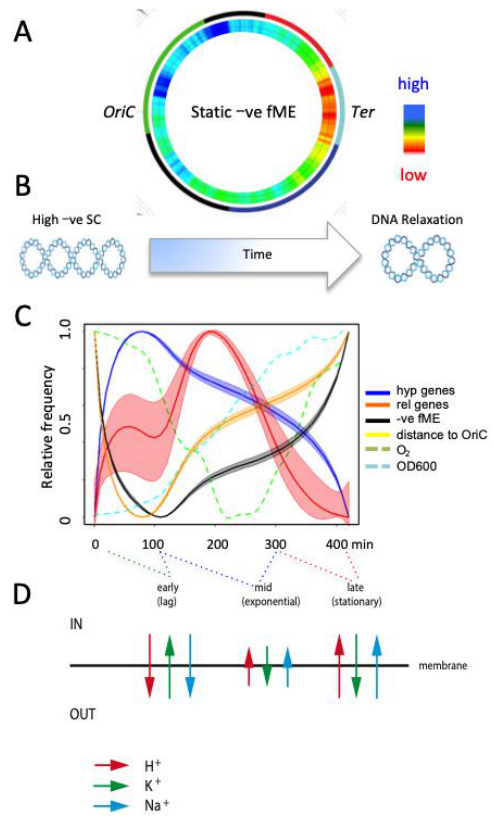
Figure 3. The proposed model of the coupling of the temporal gradient of superhelicity with spatial gradient of DNA thermodynamic stability as a device determining the spatiotemporal gene expres- sion. ( A ). The E. coli genomic wheel with macrodomains depicted on the outer ring: green — Ori; dark blue — left; red — right; black — the left and right non-structured domains; light blue – Ter mac- rodomain. On the genomic wheel, the distribution of free negative melting energy (-ve fME, inner ring; 500 kb scanning window) is color-coded in blue (for high) and red (for low). The -ve fME was defined using the parameters of Santa Lucia [173]. The positions of OriC and Ter are indicated. ( B ). The horizontal arrow indicates the passage of time after the nutritional shift-up and associated de- crease in global DNA negative superhelicity (-ve SC) during the growth cycle. ( C ). The plot showing the temporal variation in different parameters in the gene expression profile obtained during the growth cycle from inoculation of cells (at 0 min) to the late stationary phase [12]. The different curves were normalized (0;1) to compare them in one plot. Expression values of genes responding to high negative supercoiling ( hyp genes) and DNA relaxation ( rel genes) are normalized to the expression of all genes. Negative melting energy and distance to origin were averaged over all genes weighted by their expression. Because melting energy is by convention expressed as a negative ∆ G value, high melting energies have a lower (more negative) numerical value, i.e., the lower the negative melting energy value the higher the G/C content. Note that the high negative melting energy values correlate with small distances to replication origin. The envelopes of the curves indicate the standard devia- tion at 10% random remapping of the expression patterns to genes. The optical density and partial oxygen pressure, respectively, are indicated by the dashed blue and green lines. For growth condi- tions see legend in Figure 1. Abscissa — time in minutes after inoculation. Ordinate — relative fre- quency in arbitrary units. ( D ). Temporal changes of ion composition and intracellular pH. IN and OUT indicate the intra- and extracellular compartments. Arrows indicate directional (influx/efflux) changes. The colored dashed lines drawn between the panels ( C ) and ( D ) correlate the growth stages indicated in ( D ) to time intervals in ( C ). For details see the text. We have argued that the process of replication as well as of ribosomal gene transcrip- tion proceeding directionally from OriC toward Ter imposes a supercoiling asymmetry